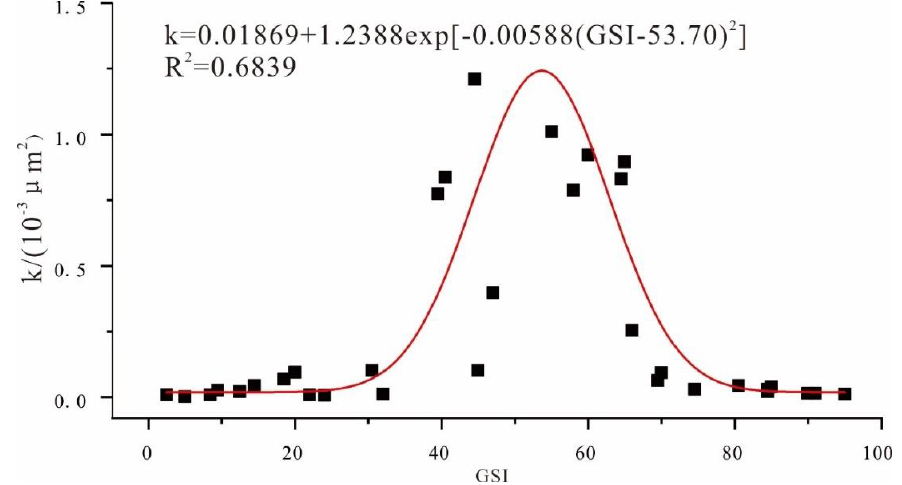
Figure 6. The relationship between GSI value and original permeability.